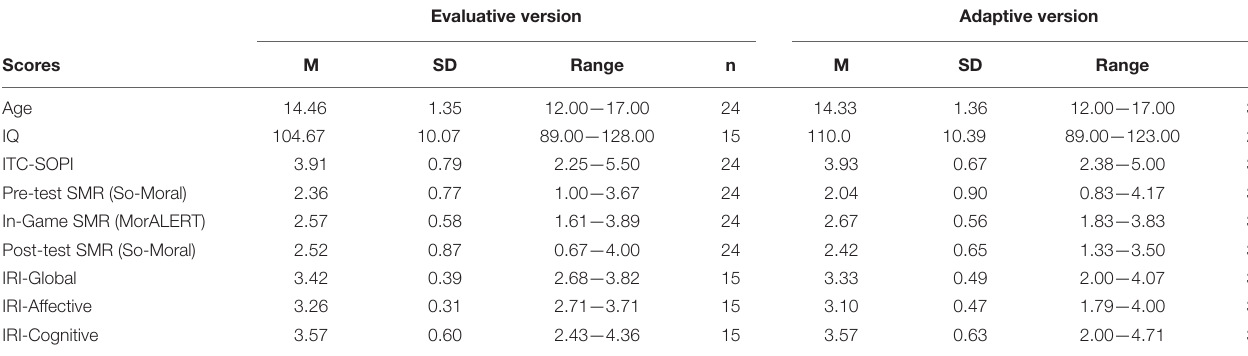
TABLE 2 | Age and results on measures of interest according to group (evaluative and adaptive versions of MorALERT).